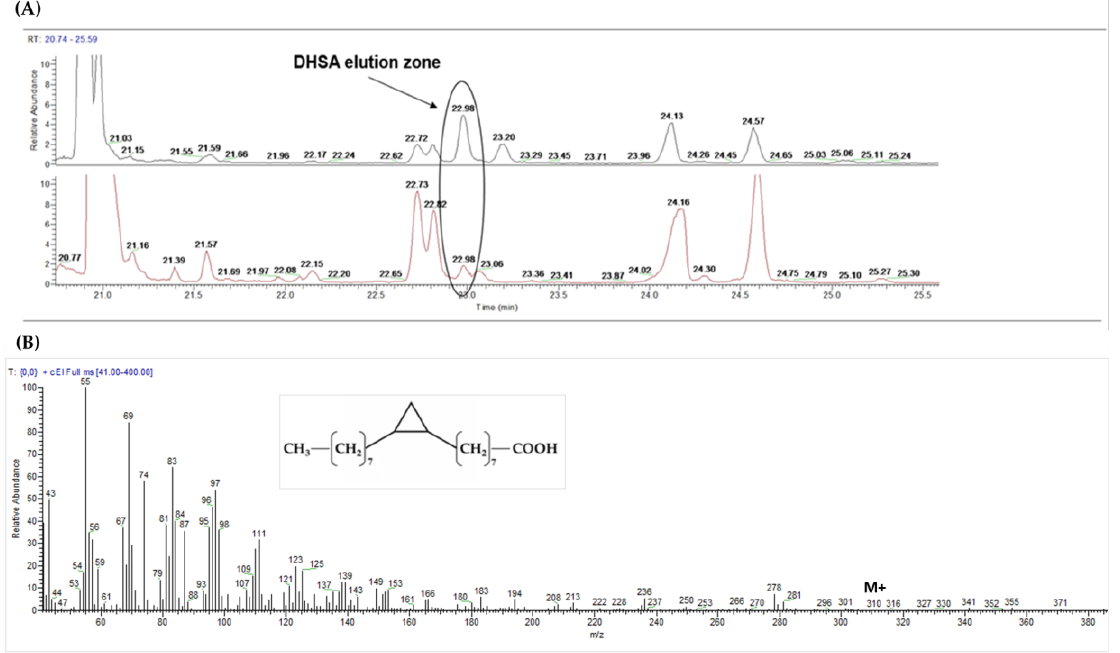
Figure 2. GC-MS detection of cyclopropane fatty acids in human plasma. DHSA: dihydrosterculic acid. ( A ) zoom of the elution zone (retention time: 22.98 min) of DHSA methyl ester in spiked plasma fat at t00 (black) compared with that detected in human plasma of one subject at t6 (red); ( B ) DHSA chemical structure and mass spectrum detected in human plasma sample at t6 (full SCAN mode; characteristic ion: m / z 278; M + : m / z 310).